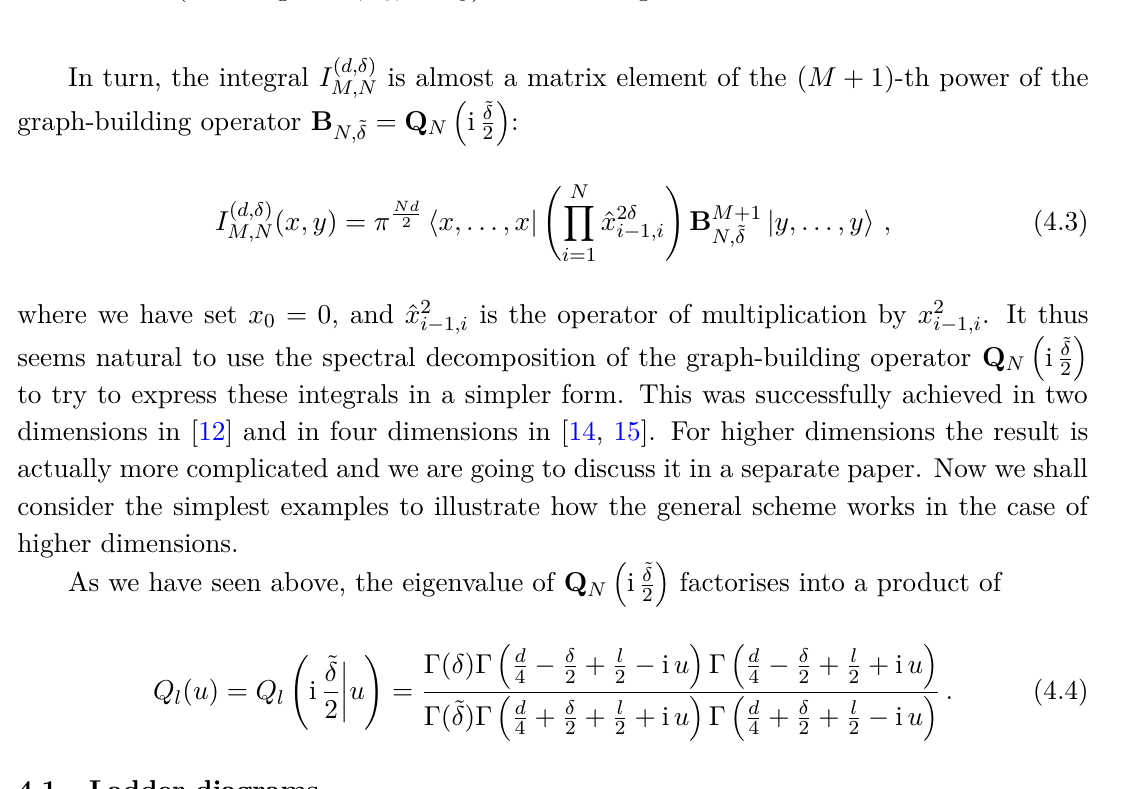
Figure 17 . Feyman graphs investigated in section 4 in the case ( M, N ) = (3 , 4) . We call G ( d,δ ) ( x 1 , x 2 , x 3 , x 4 ) and I ( d,δ ) ( x, y ) the integrals represented by the graph on the left and on the M,N M,N right respectively. All the vertical (or ending on x 2 , x 4 or 0 ) segments have weight δ whereas all the horizontal (or ending on x 1 , x 3 , x or y ) ones have weight ˜ δ